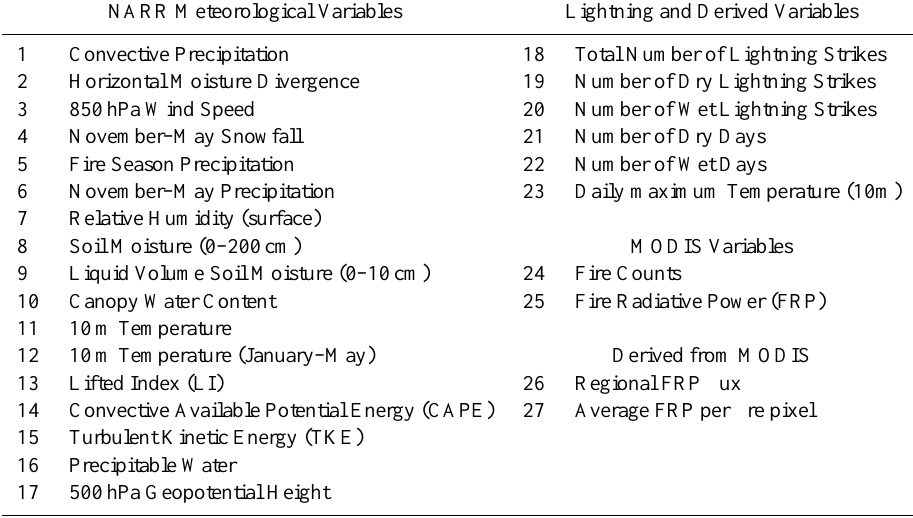
Table 2. Analysis variables.